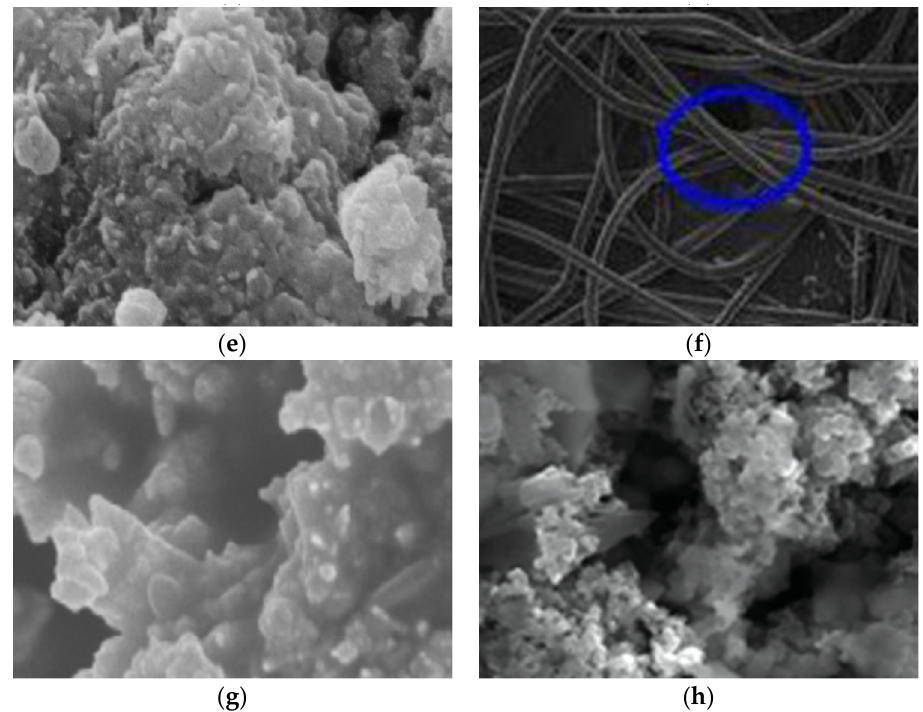
Figure 5. SEM images of some representative PANI and PANI-based polymer composites. ( a ) Reprinted with permission